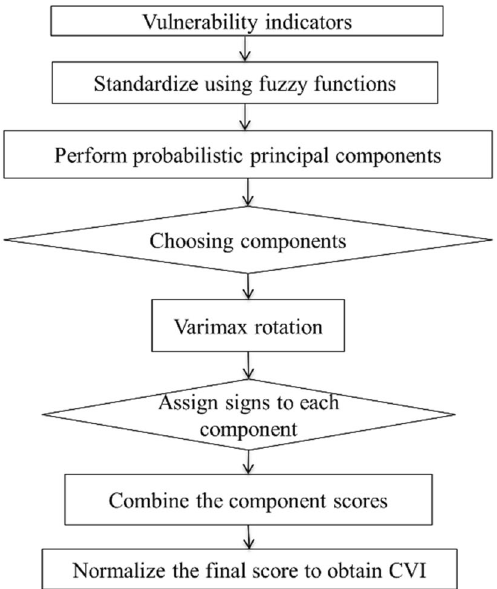
Figure 2. Probabilistic Principal Component Analysis based vulnerability analysis